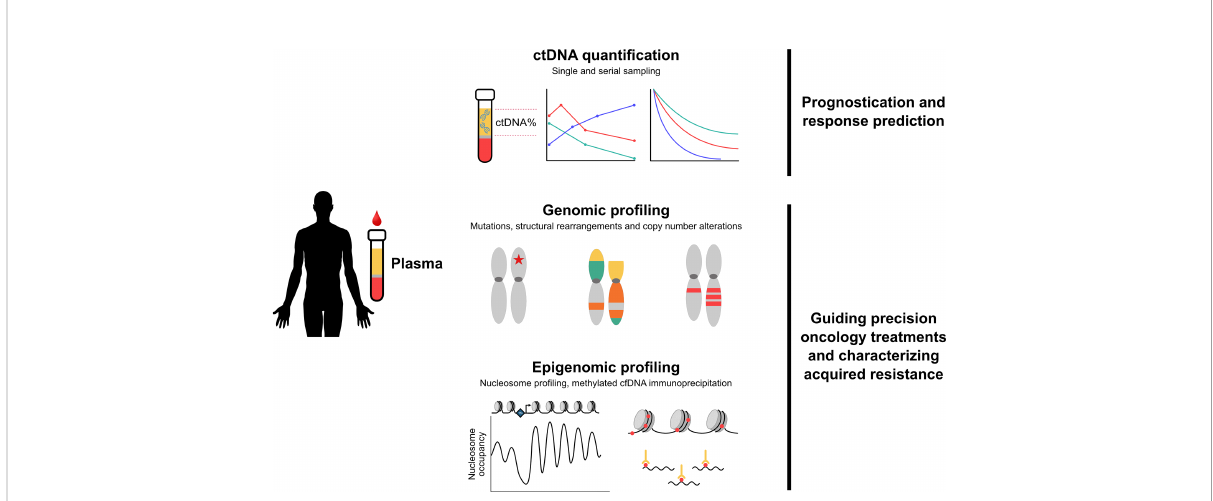
FIGURE 2 Overview of clinical applications of plasma ctDNA in metastatic prostate cancer. Quanti fi cation and genomic/epigenomic pro fi ling of plasma ctDNA has identi fi ed multiple clinical applications relevant to metastatic prostate cancer. Top - ctDNA% is highly prognostic and outperforms standard clinical prognostic factors. Tracking changes in ctDNA% over time may represent a reliable early readout of treatment ef fi cacy. Middle - characterization of mutations, structural rearrangements and copy number alterations guides use of targeted therapies and enables detection of evolving treatment resistance. Bottom - novel epigenomics approaches are capable of identifying aggressive subtypes of prostate cancer, including emergence of small cell/neuroendocrine disease. Abbreviations: cfDNA, cell-free DNA; ctDNA, circulating tumor